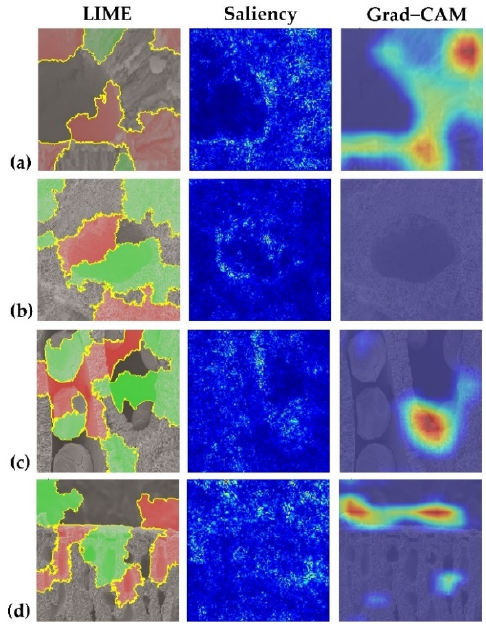
Figure A1. Examples of SEM images that were not assigned to a specific category: ( a ) Lithophyllum racemus pore canal; ( b ) a magnification showing perithallial cells near the pore canal. These features proved to be significant contributors to the correct classification of Lithophyllum spp. in the 2 and 3 class − CNNs.